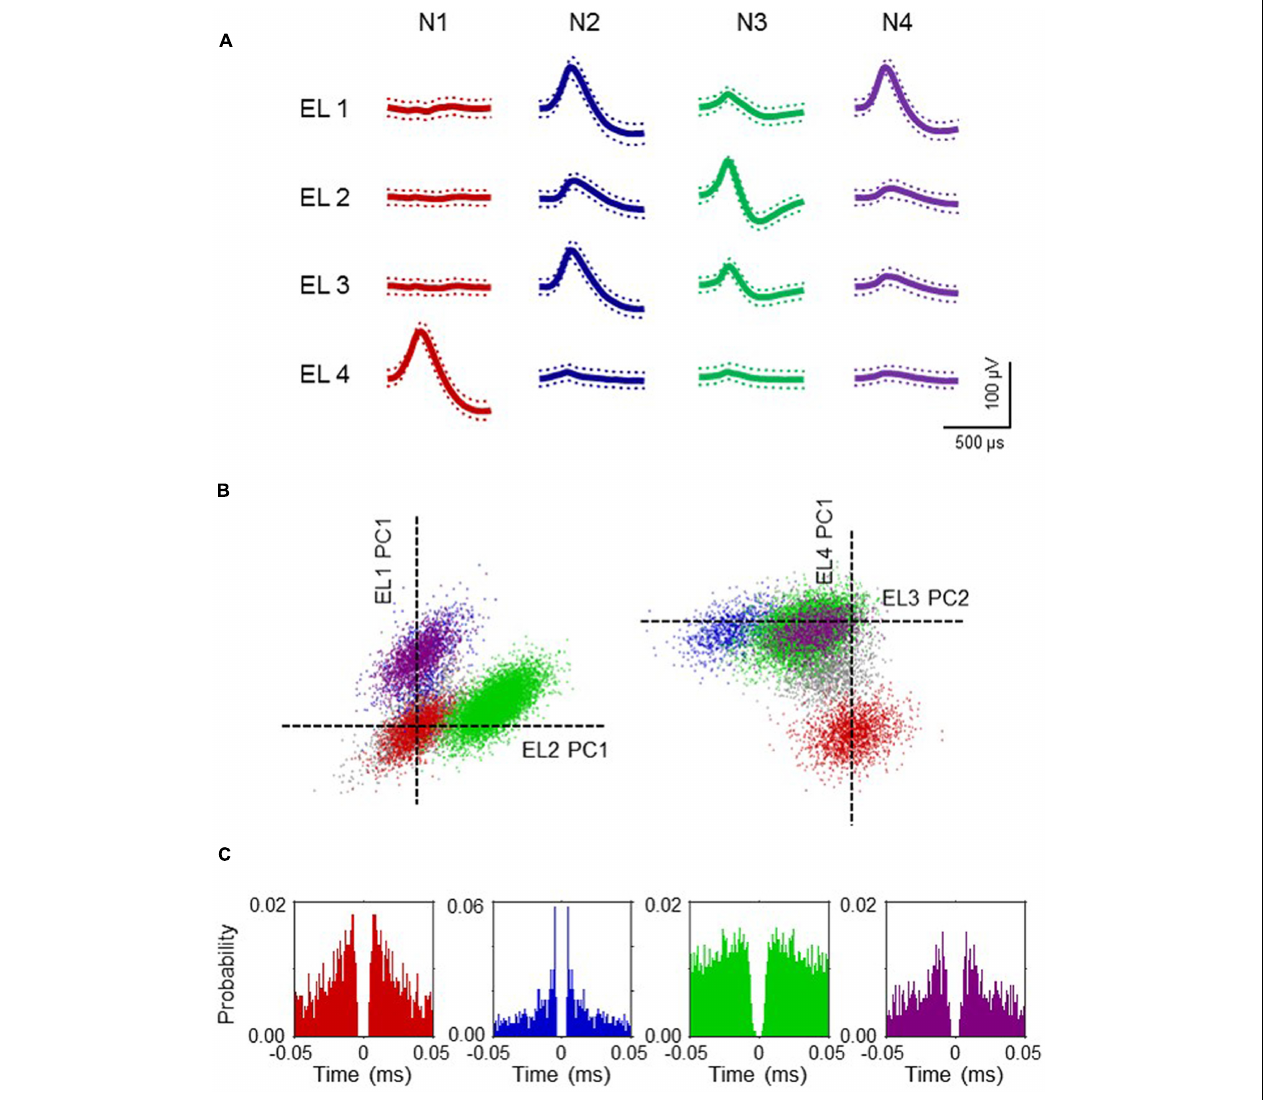
FIGURE 4 | Example waveforms of four NA neurons isolated by an offline cluster analysis. (A) Waveforms (mean ± SD, dotted) recorded from four electrodes (tetrode) (EL 1–4). The waveforms indicated by N 1–4 correspond to four neurons, identified by the offline cluster analysis in (B) . (B) The results of an offline cluster analysis. Each axis represents a principle component (PC1 or 2). Each dot represents one neuronal spike. The semi-automatic spike sorting resulted in the four colored clusters of neural signals. Gray dots represent unsorted spikes. The axes represent the first principle component of each of the four electrodes. Four colored clusters (red, blue, green and purple, corresponding units N 1–4 in A , respectively) are recognized. (C) Autocorrelograms of the neurons. Bin width = 1 ms. Ordinates indicate probability, where bin counts were divided by the number of spikes in the spike